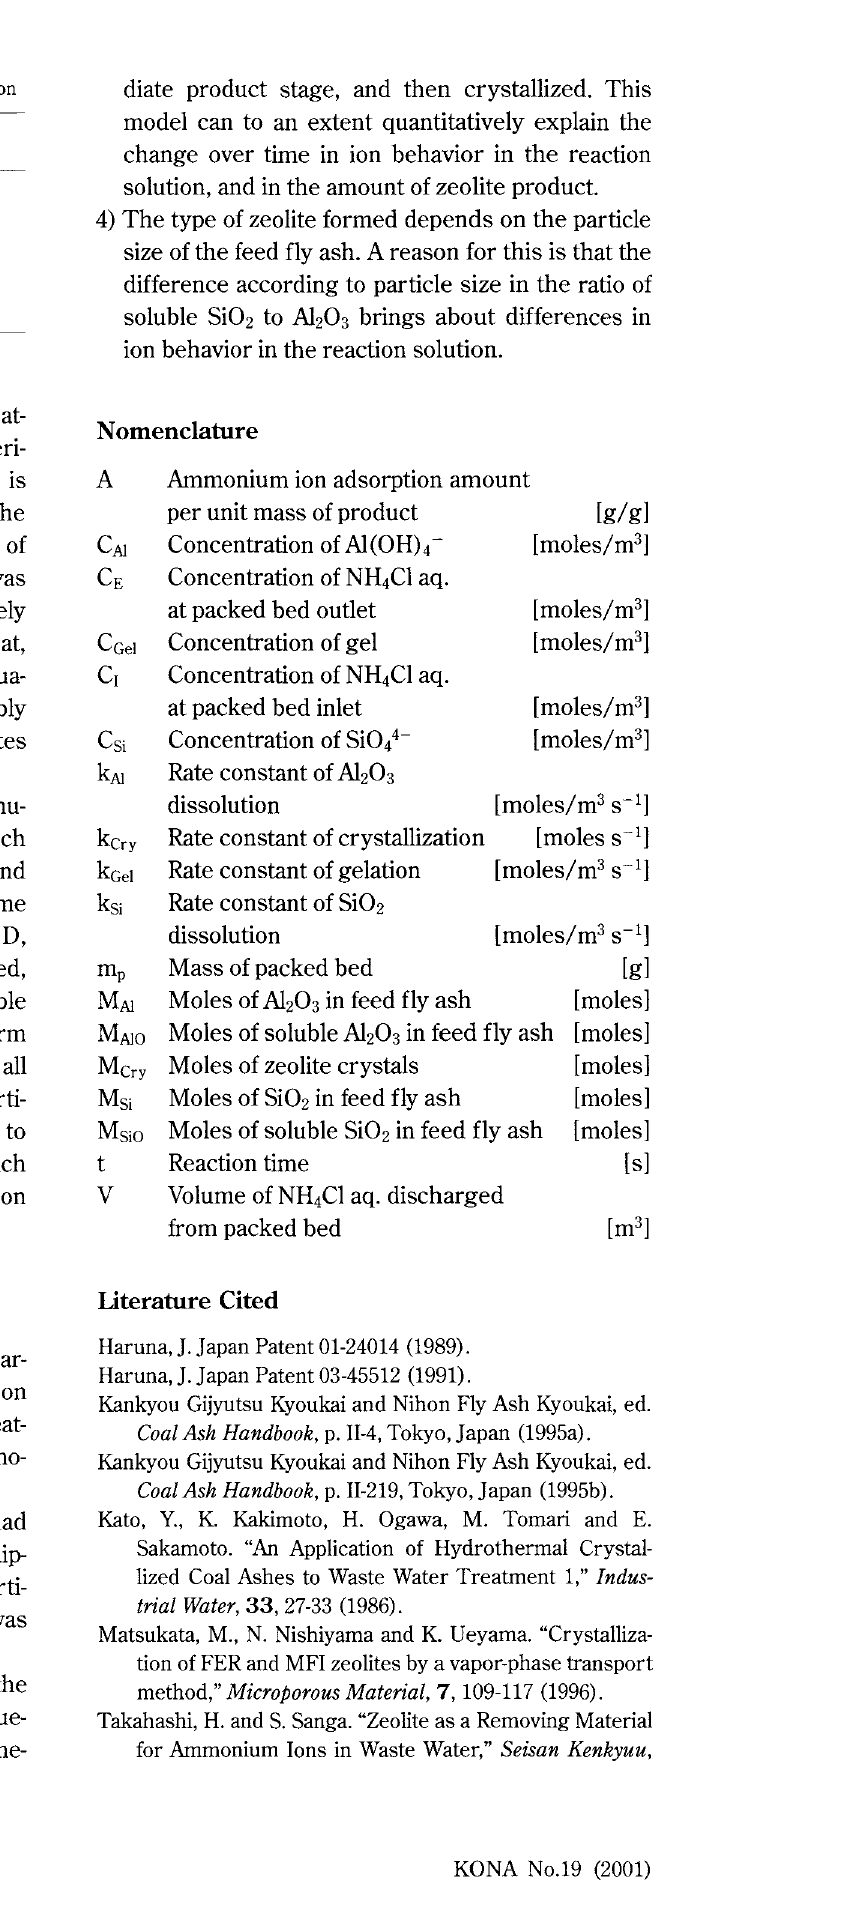
Table 3 Values of parameters optimized by numerical